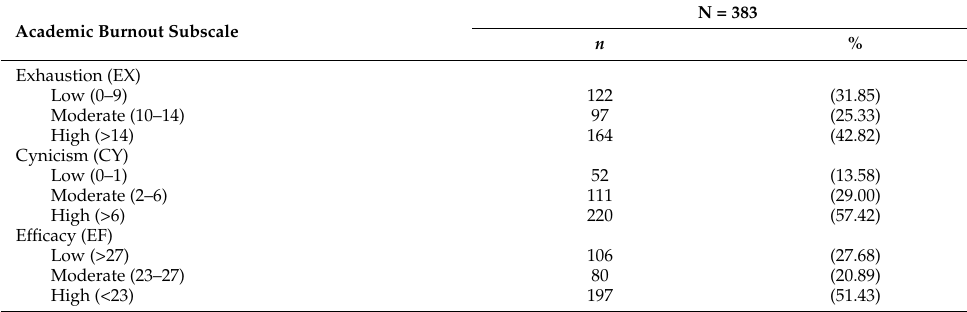
Table 2. Prevalence of academic burnout among respondents (N = 383).